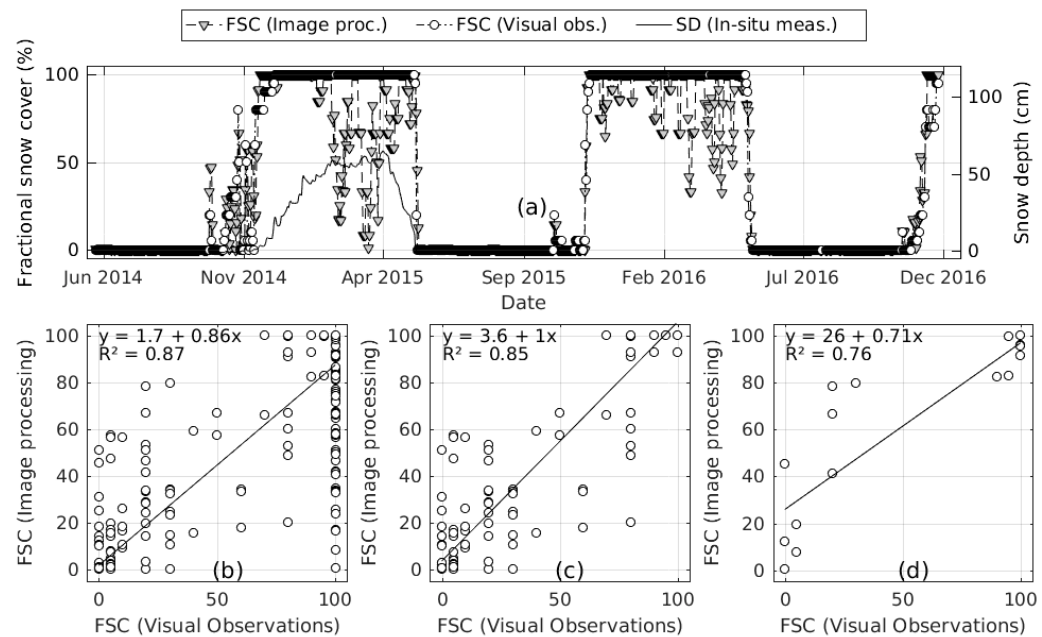
Figure 13. Sodankylä wetland camera: ( a ) 3-day moving window averaged fractional snow cover over time from image processing and daily visual observations, daily averaged snow depth over time from automatic ground measurements. Distribution and regression of fractional snow cover from image processing versus visual observations for ( b ) all data; ( c ) early season; and ( d ) melting season.